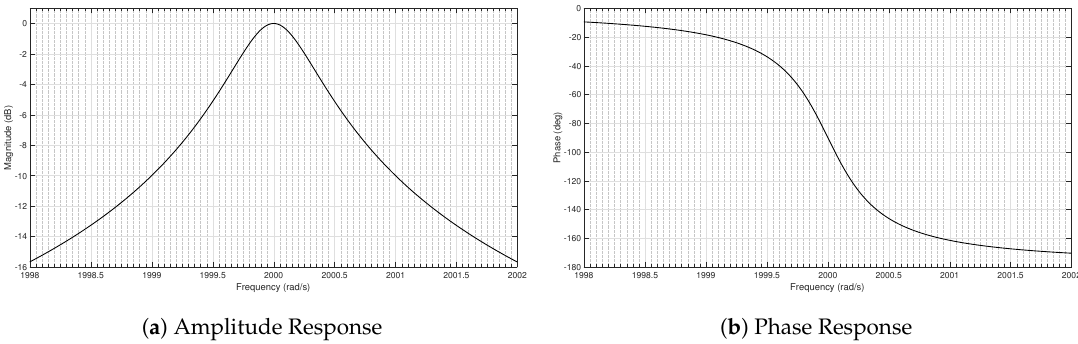
Figure 1. Amplitude and Phase response of the theoretical model close to the resonance